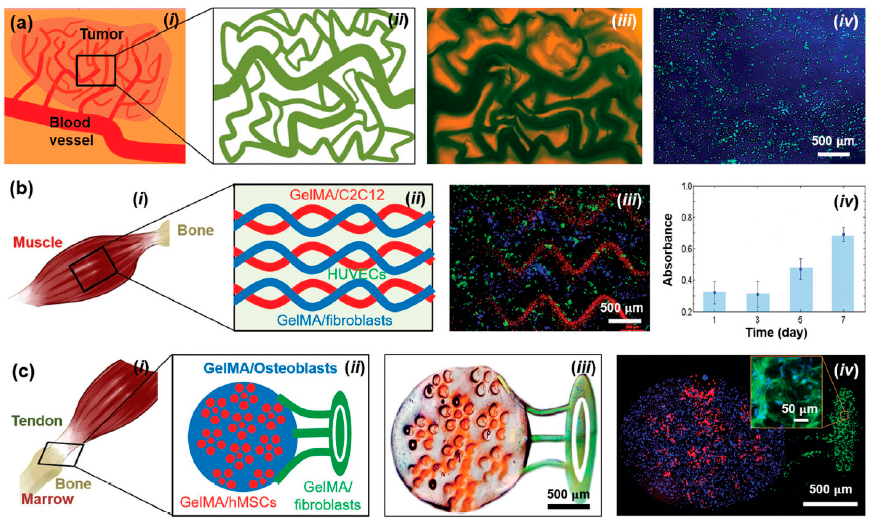
Figure 38. ( a ) Tumor angiogenesis model: ( i ) illustration of tumor angiogenesis model; ( ii ) schematic of the mask for 3D printing; ( iii ) bioprinted MCF7 cell-laden microvascular bed of GelMA (blue); ( iv ) bioprinted cell-laden microvascular bed of GelMA (blue) seeded with cells (green) in the channels. ( b ) Skeletal muscle model: ( i ) schematic showing the skeletal muscle tissue; ( ii ) schematic of the mask for 3D printing; ( iii ) bioprinted structure of GelMA containing patterned cells (red) and fibroblasts (blue); ( iv ) Presto blue measurements of cell proliferation in the printed structures. ( c ) Tendon-to-bone insertion model: ( i ) schematic of the tendon-to-bone insertion site; ( ii ) schematic of the mask for printing; ( iii ) bright field optical image showing a bioprinted dye-laden GelMA structure; ( iv ) bioprinted structure of GelMA containing patterned osteoblasts (blue), MSCs (red), and fibroblasts (green). Produced with permission from [331]. Copyright © 2022 John Wiley and Sons.